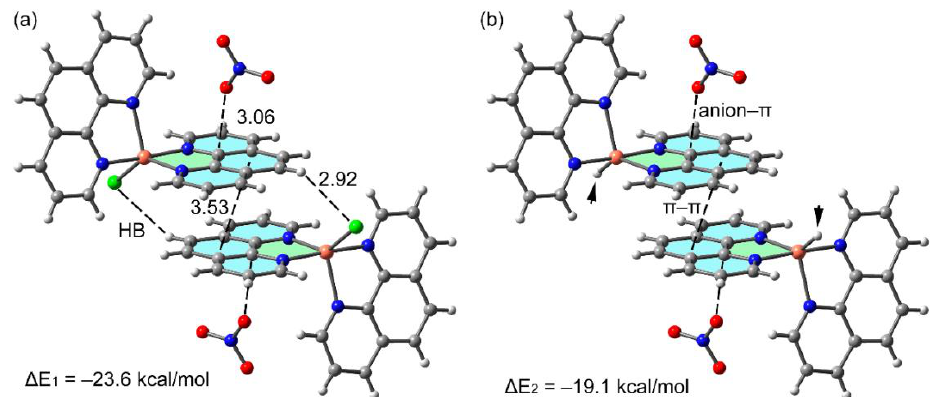
Figure 7. Complete ( a ) and mutated ( b ) theoretical models used to evaluate the π-stacking and C–H···Cl H bonds in compound 1 . The distances were measured in Å.